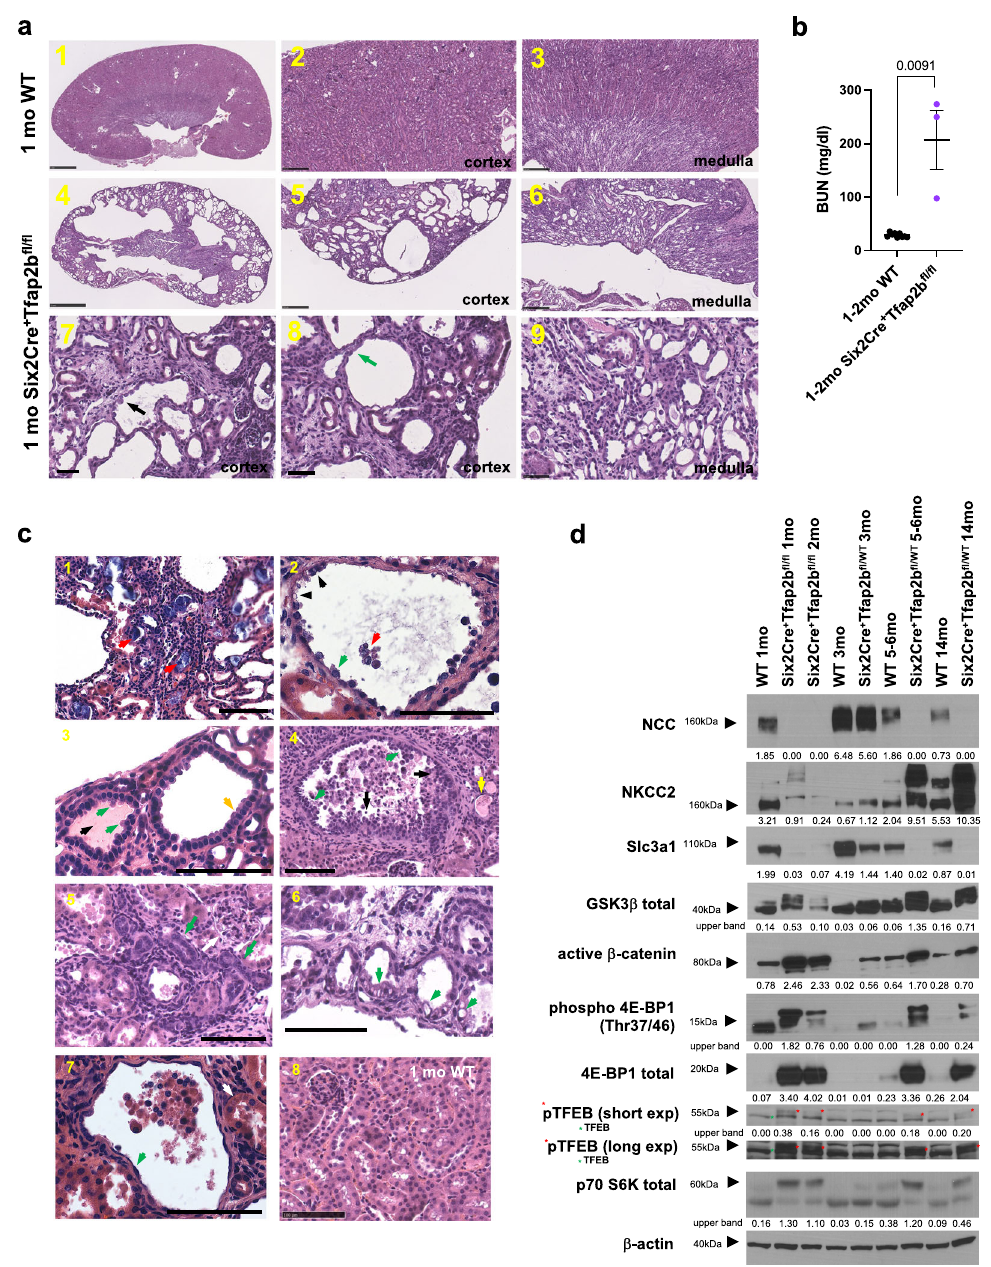
does not impair DCT formation (Fig. 6a; Supplementary Fig. S12b), consistent with a critical role of AP-2 β for the tran- sition of distal nephron precursors into early-stage DCTs 17